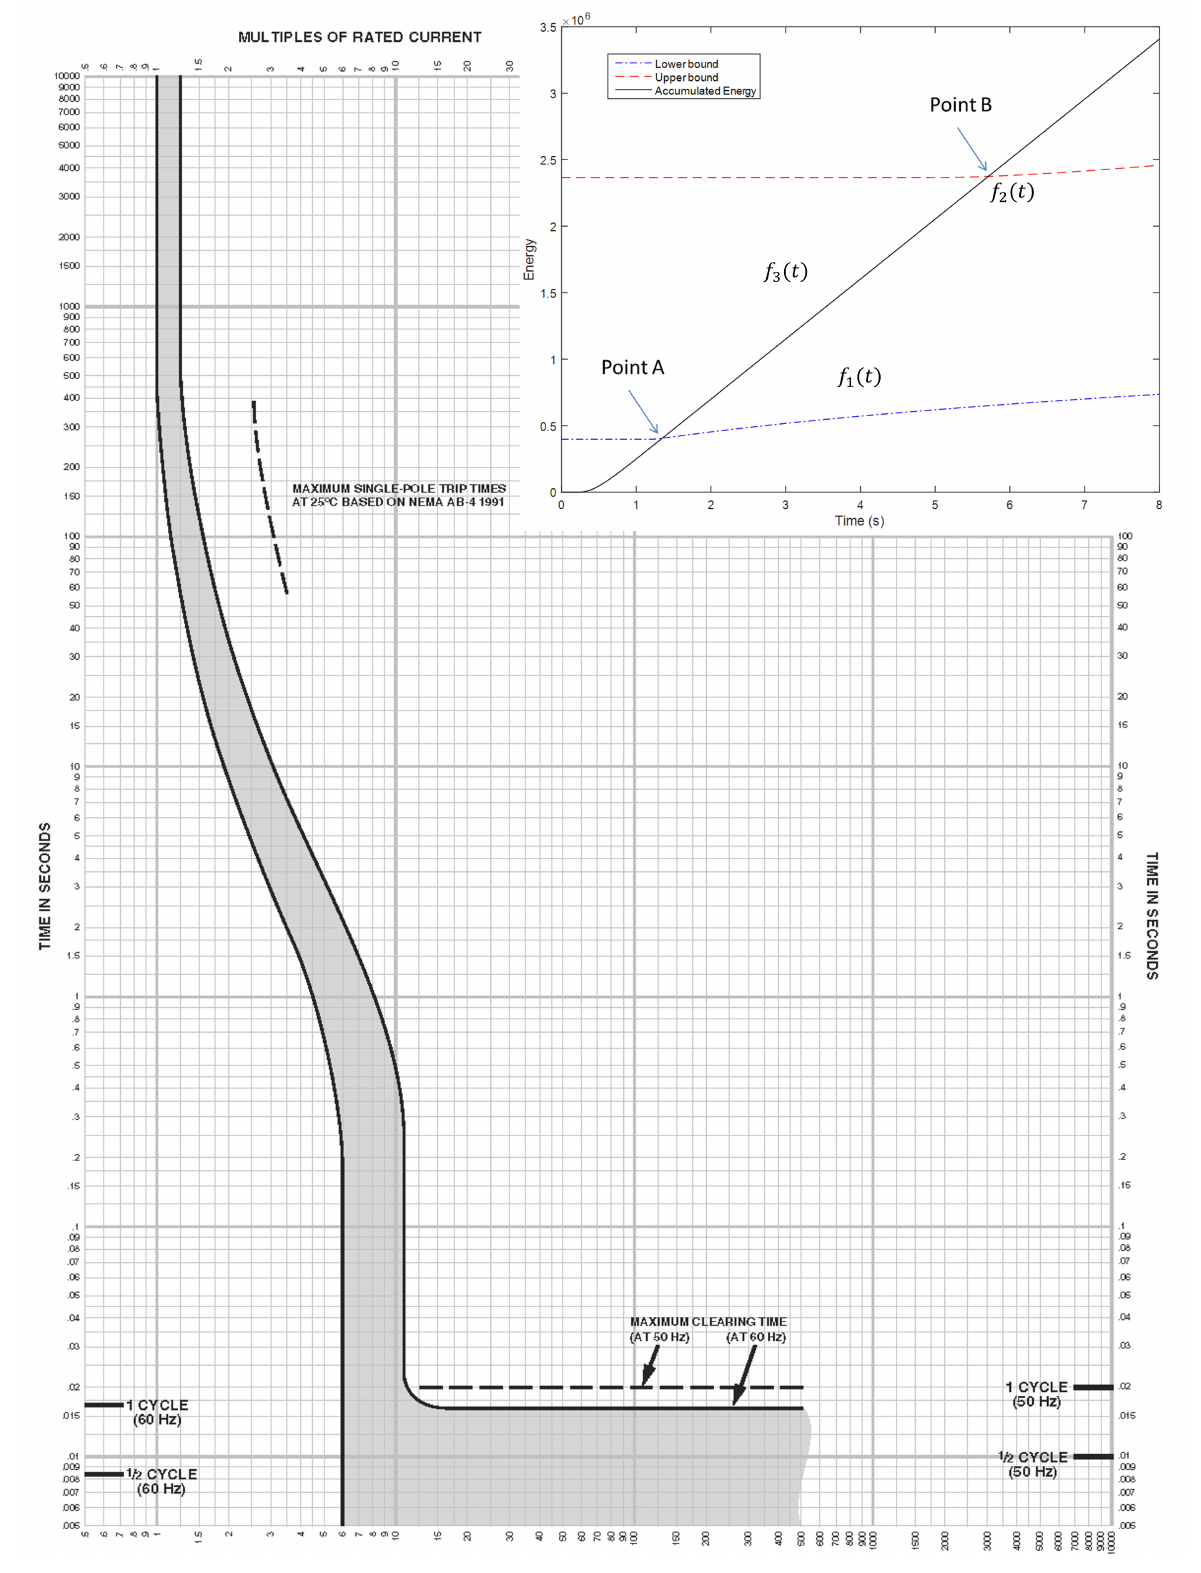
Figure 3. The thermal tripping interval of the Square D QOB-3100 Circuit Breaker [18]. From the manufacturer’s TCC data sheet, we can obtain two curves regarding to the catalog energy by taking a change of coordinates using Equations (2) and (5). The lower-boundary curve, i.e., f 1 ( t ) , is based on the “minimum clearing time” , and the